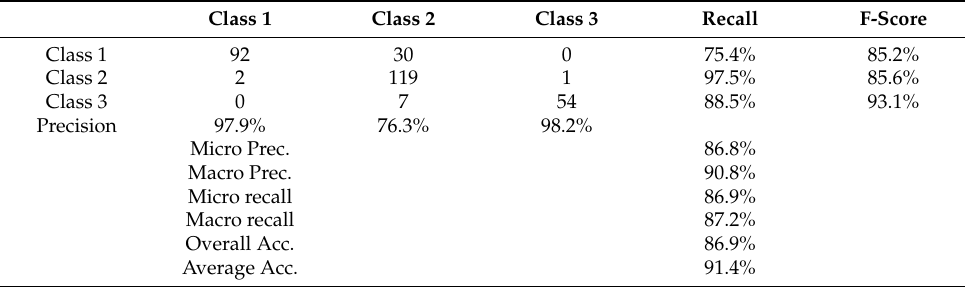
Table 5. The classification by ResNet with 18